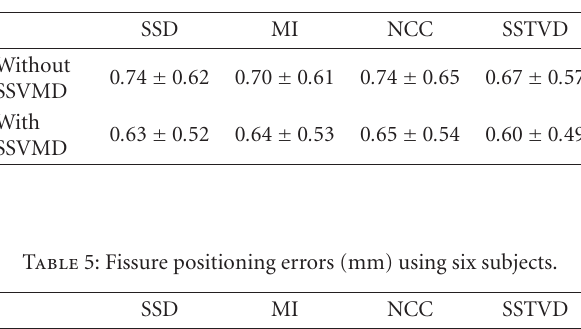
Table 5: Fissure positioning errors (mm) using six subjects. SSD MI NCC SSTVD Without